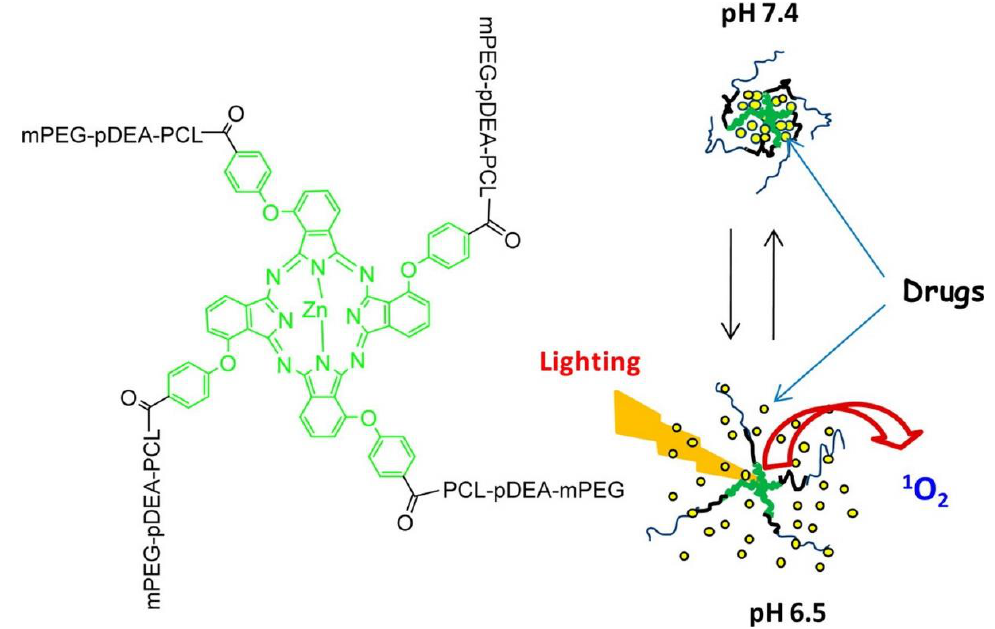
Figure 10. Molecular structure of PDCZP and illustration of its pH-dependent drug release and combination of chemotherapy and photodynamic therapy. Reproduced from [169] with permission, copyright 2017, American Chemical Society.